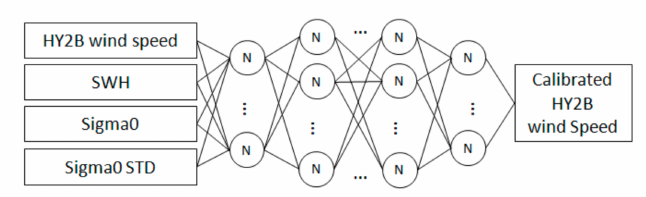
Figure 8. The structure of deep neural network for wind speed calibration scheme